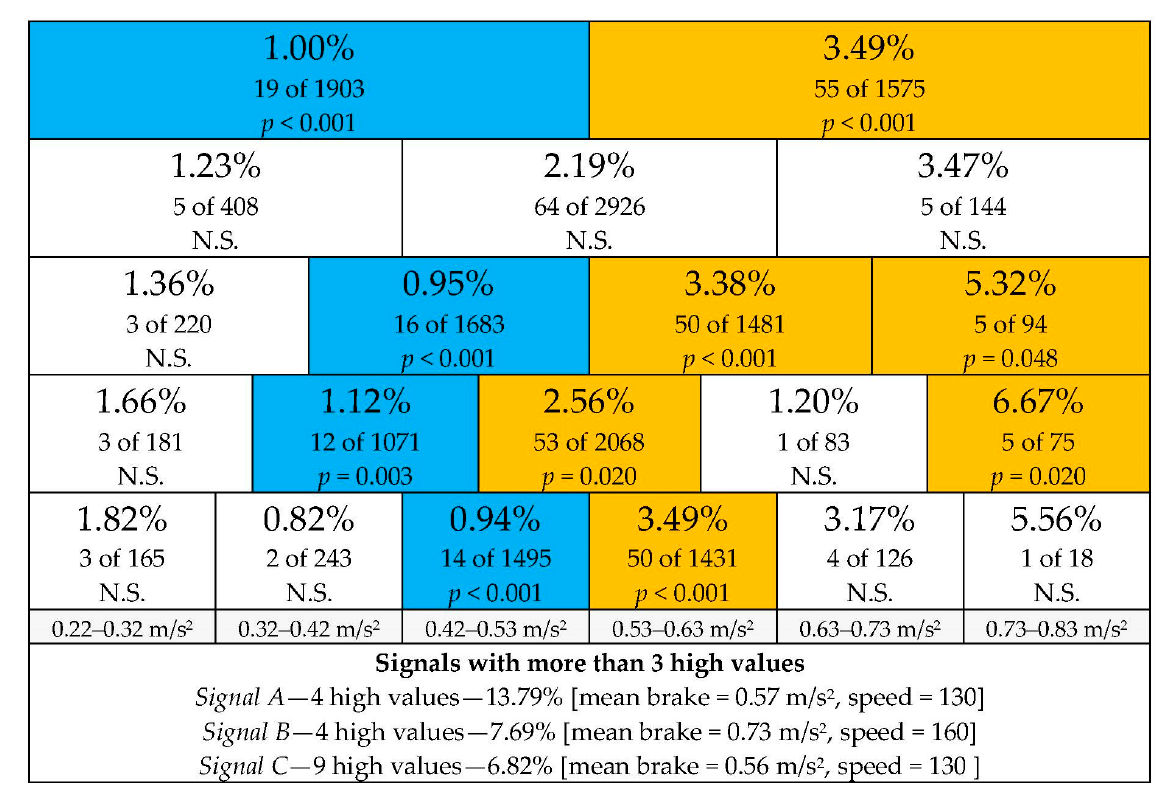
Figure 13. Mean deceleration effect analysis. This figure shows the results when the mean deceleration is split five different ways. The percentages refer to the percentage of high values in a segment. The numbers directly below indicate the number of high values and the total. Orange indicates that the percentage is significantly higher than expected and blue indicates a percentage significantly lower than expected. White color indicates a non-significant result. The mean deceleration value ranged from 0.22 to 0.83 m/s 2 . The mean percentage was 2.1%.